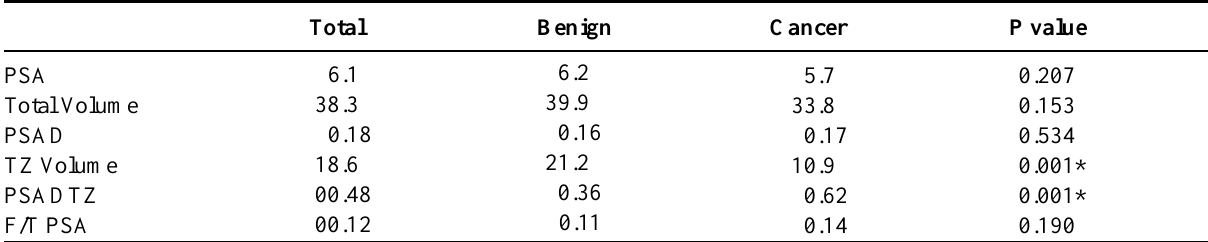
Table 1 – Association between pathology examination and PSA parameters (mean) in the general group.